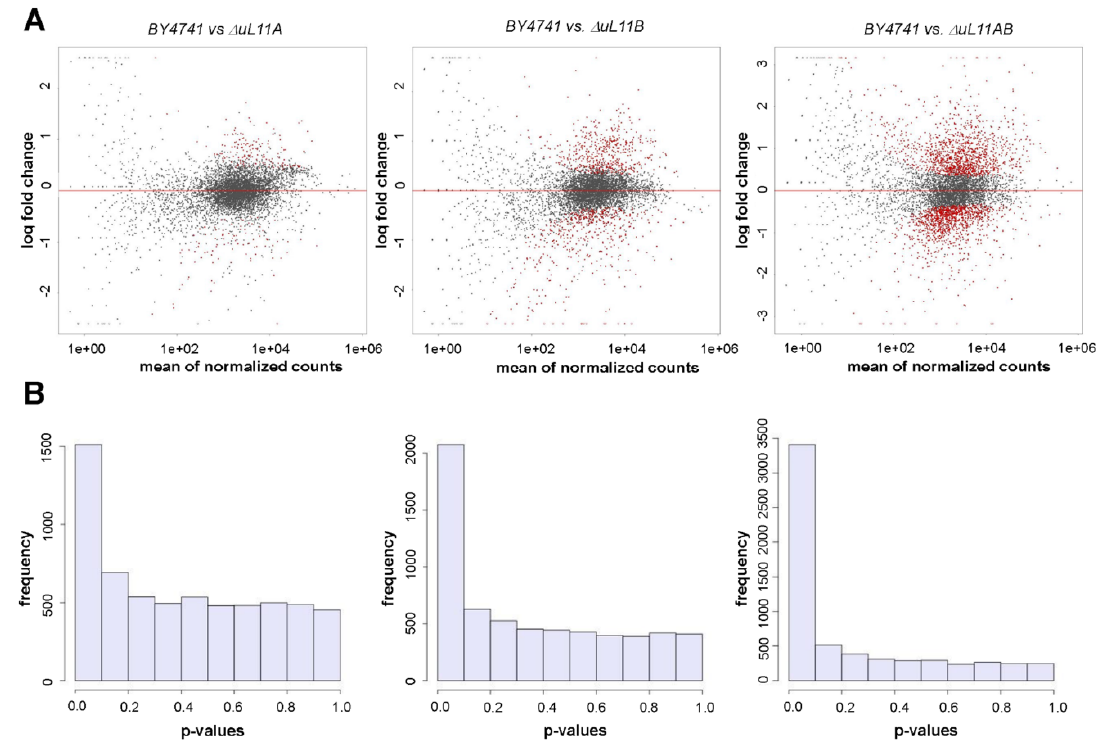
Figure 8. Gene expression analysis. Relationship between logarithmic fold change and normalized averaged expression for a given gene (each point on the graph represents the value for the single genes). Negative values mean that the expression in the mutant was lower than in the BY4741, while positive values mean that the expression in the BY4741 was lower than in the mutant. Genes with FDR < 0.05 are marked in red ( A ). Histogram of p-values obtained in a statistical test (Wald test) for the significance of the change in gene expression prepared with DESeq2 software ( B ).